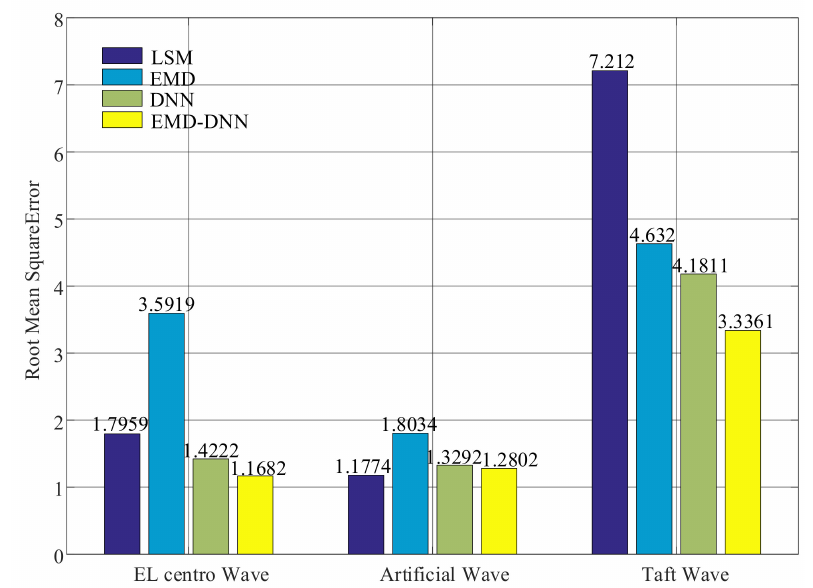
Figure 14. Root mean squares error (RMSE) of different correction